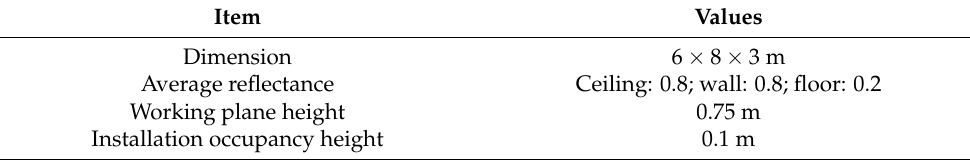
Table 3. Details of senior office